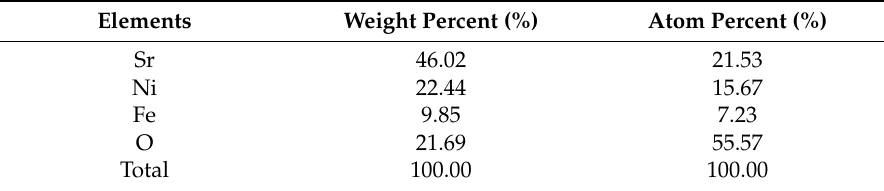
Figure 13. EDX spectrum of SrFe 0.3 Ni 0.7 O 2.85 perovskite. Figure 13 . EDX spectrum of SrFe 0.3 Ni 0.7 O 2.85 perovskite. Table 4. The relative content of elements in SrFe 0.3 Ni 0.7 O 2.85